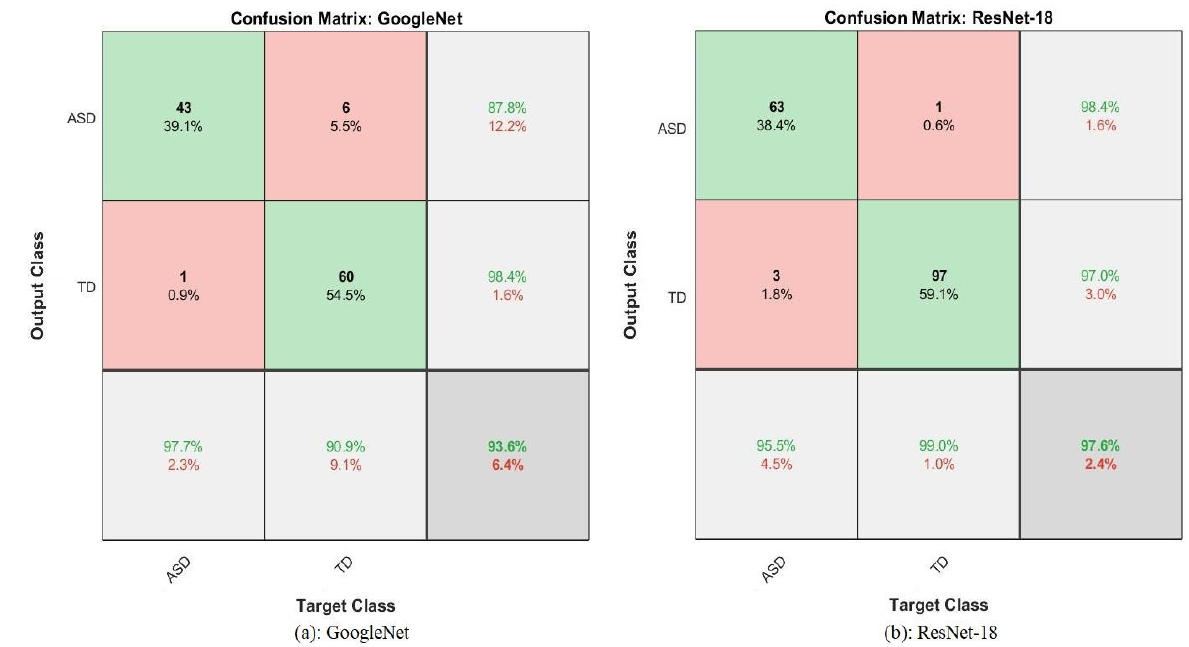
Figure 17. Confusion matrices of ASD dataset. ( a ) GoogleNet and ( b ) ResNet-18.